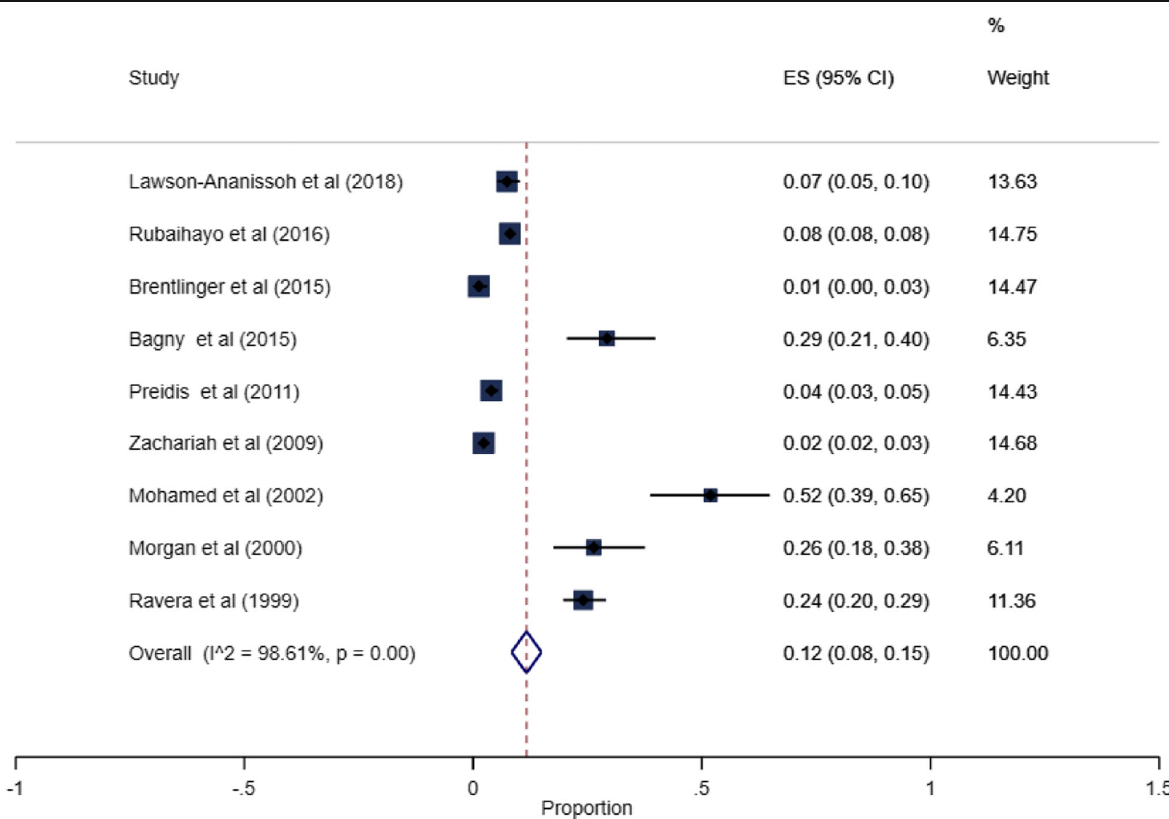
Fig. 2 The pooled prevalence of HIV-associated esophageal candidiasis in sub-Saharan Africa